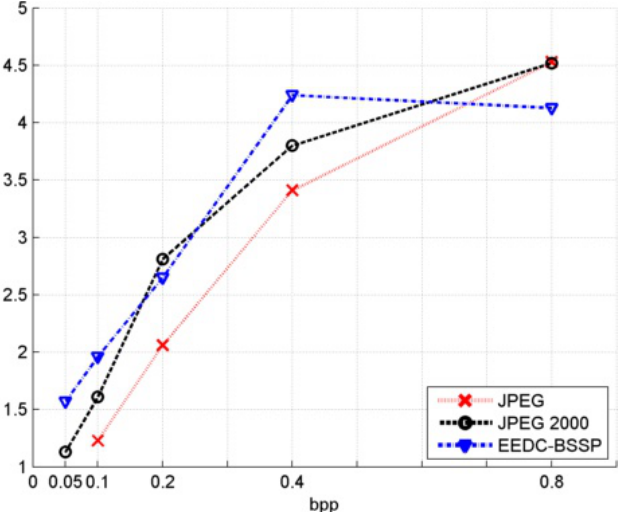
Figure 18. MOS values comparison for EEDC-BSSP with JPEG and JPEG 2000 for image horse .